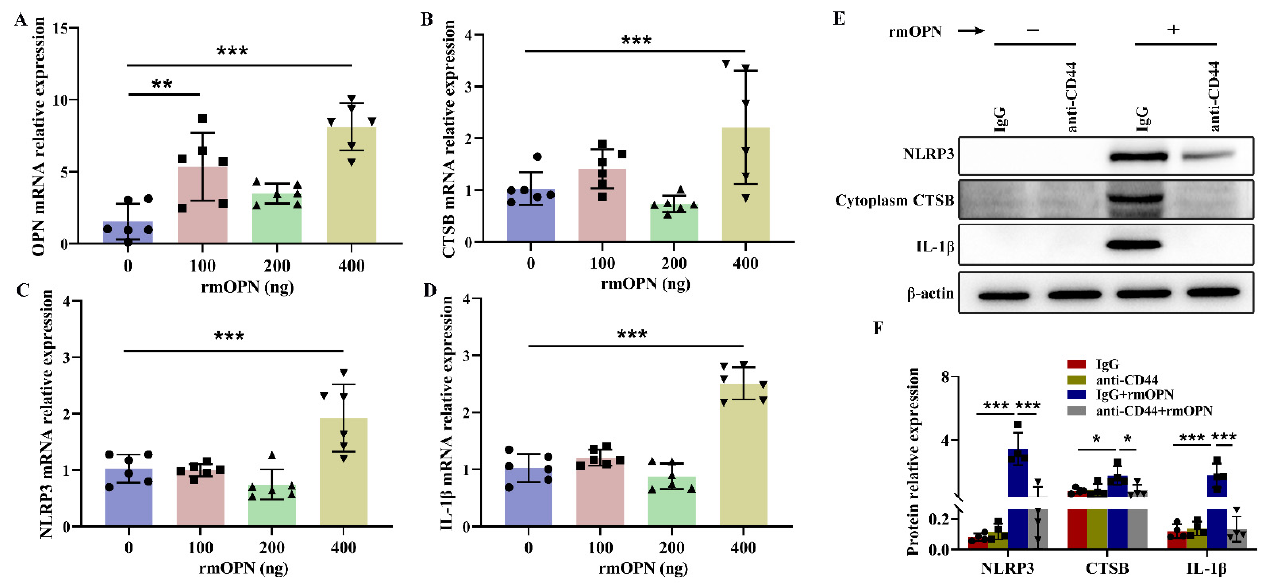
Figure 8. Secreted OPN regulated the inflammatory response by interaction with CD44 in vitro. ( A – D ) qRT-PCR was used to determine the expressions of OPN, CTSB, NLRP3, and IL-1 β in BV-2 cells incubated with rmOPN (100, 200, and 400 ng/mL) ( n = 6). ( E , F ) Western blot analysis of NLRP3, cytoplasmic CTSB, and IL-1 β to 24 h of IgG or anti-CD44 treatment with/without rmOPN (400 ng/mL) treatment in BV-2 cells ( n = 4). All experiments were performed three times. Values represent the mean ± SD, ** p < 0.01, *** p < 0.001 according to one-way ANOVA with Dunnett correction in ( A – D ). * p < 0.05, *** p < 0.001 according to one-way ANOVA with Bonferroni corrections in ( F ). CTSB, cathepsin B; IL-1 β , interleukin-1 β ; NLRP3, NOD-like receptor thermal protein domain-associated protein 3; OPN, osteopontin; rmOPN, recombinant mouse OPN.